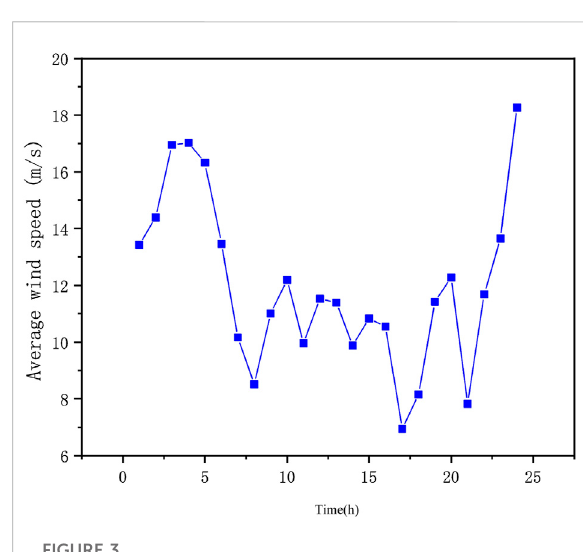
FIGURE 3 Average wind speed forecast in the next 24